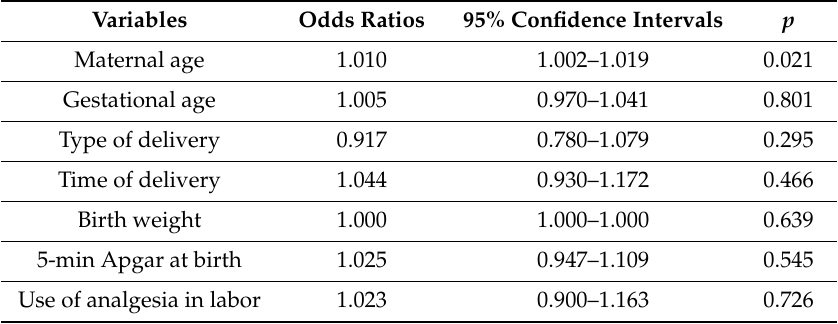
Table 5. Logistic regression analysis considering the period including the two weeks pre and post DST as the dependent variable and the other parameters investigated the independent